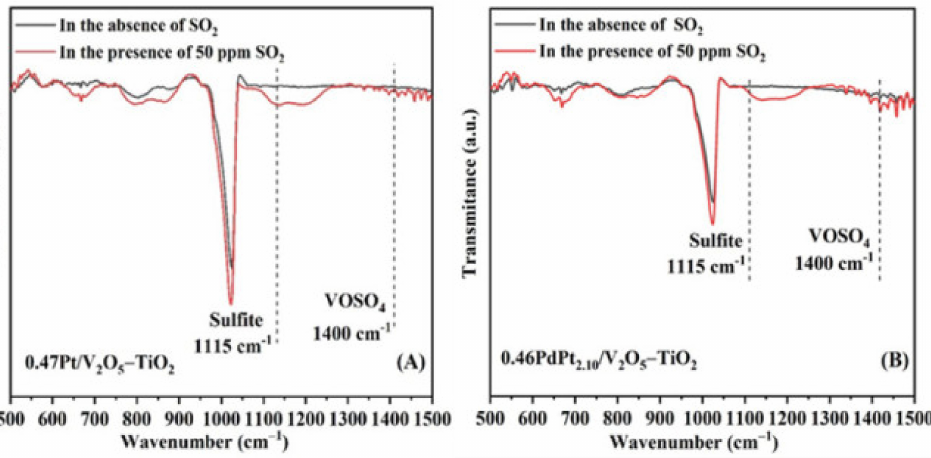
Figure 8. FT-IR spectra of the ( A ) 0.47Pt/V 2 O 5 -TiO 2 and ( B ) 0.46PdPt 2.10 /V 2 O 5 -TiO 2 samples in the presence and absence of 50 ppm SO 2